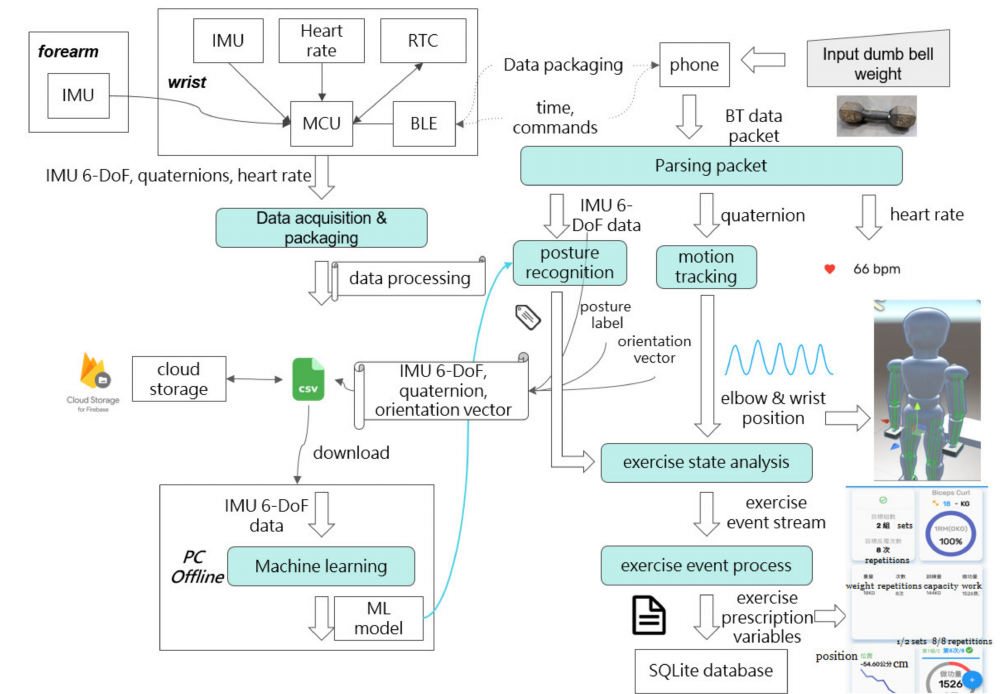
Figure 1. System